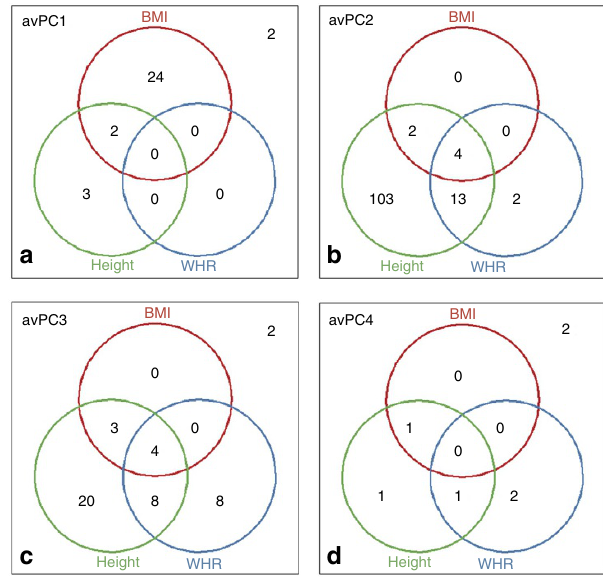
Figure 3 | Number of loci associated with AvPCs and known from previous GIANT analyses on BMI, WHR or height. ( a–d ) corresponds to each AvgPC respectively. The Venn diagrams specify for each AvPC how many significantly associated loci (promising P value in the first stage meta analysis ( o 5 (cid:2) 10 (cid:3) 6 ) and genome wide significant in first and second stage combined analysis ( o 5 (cid:2) 10 (cid:3) 8 )) are known from previous GIANT analysis on BMI, height or WHR. In the upper right corner of each plot the number of loci is given that are not known from previous GIANT